Question: Generate an informative caption for the figure above.
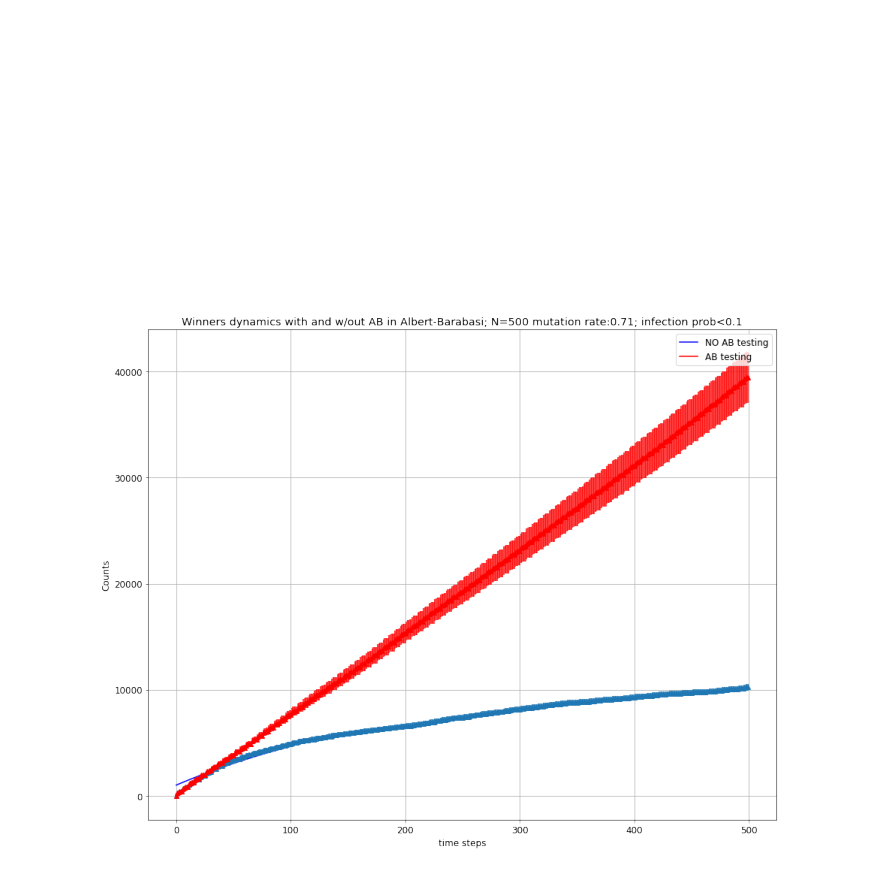
Answer: Comparison of the fist-ranked linguistic feature dynamics in both explored scenarios, a pure social spreading setting and an A/B testing led one. The network structure employed in the simulation is the Albert-Barabasi one.